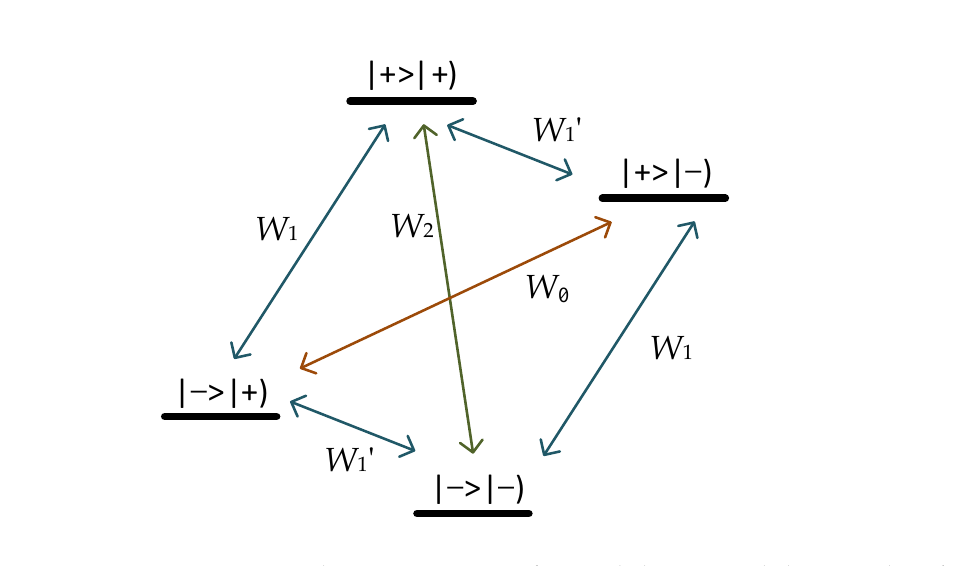
Figure 2. Energy diagram appropriate for coupled proton and electron, where |+>|+), |−>|−), |+>|−), and |−>|+) are the four energy levels, respectively.